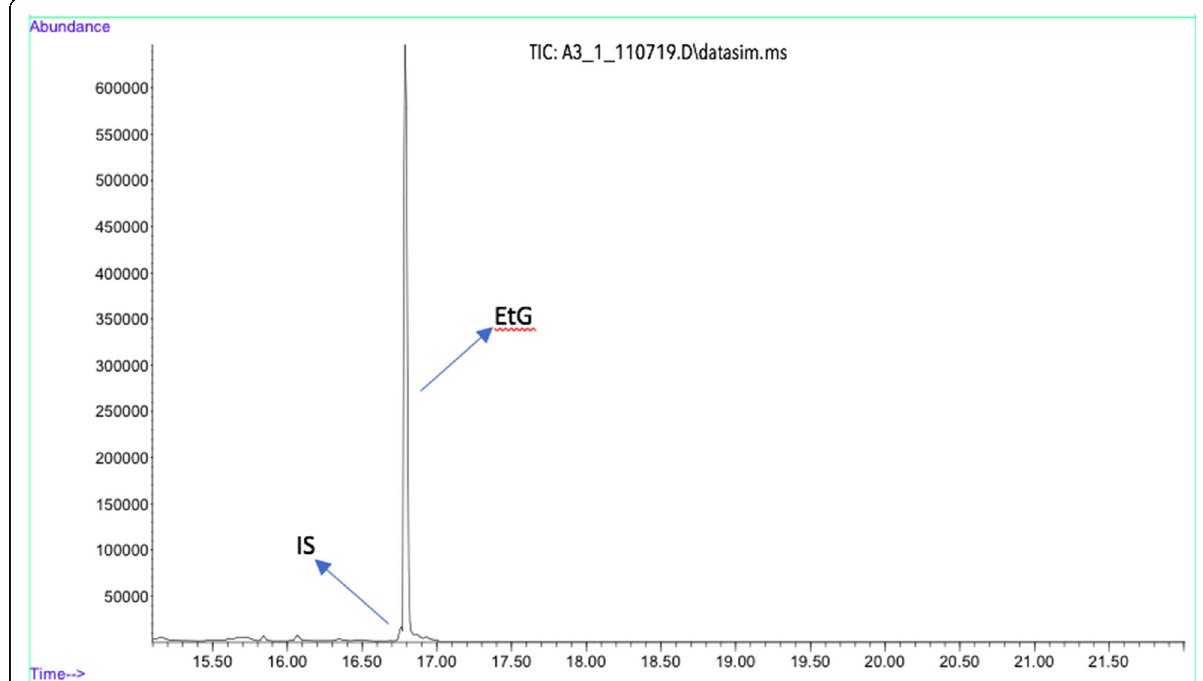
Fig. 5 Chromatogram of a patient ’ s urine showing presence of EtG (83,329